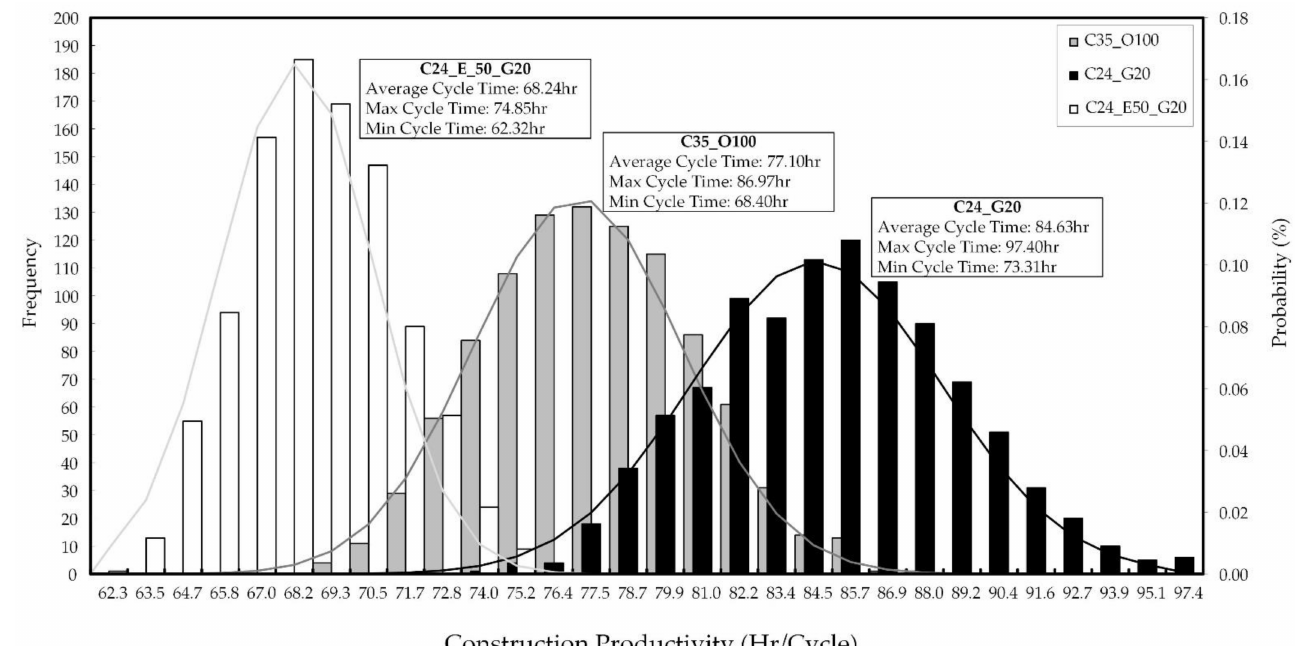
Figure 19. Result of the construction productivity analysis based on elapsed